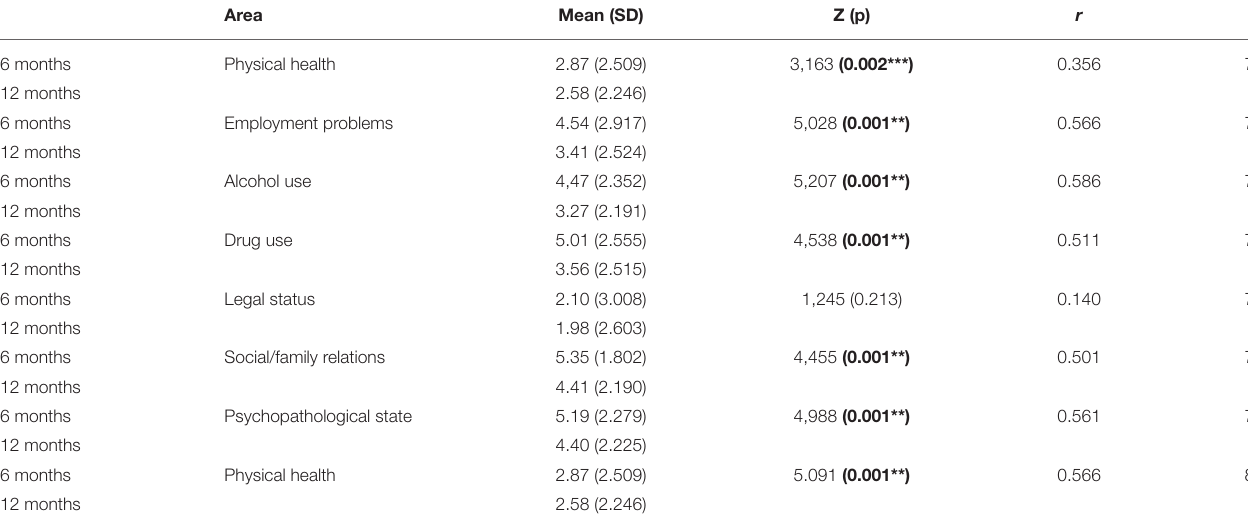
TABLE 4 | Differences between 6-month and 12-month